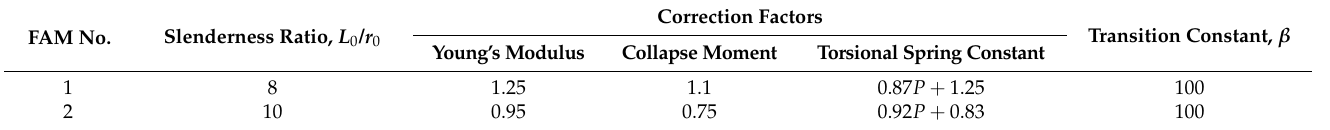
Figure 11. Experiment setup using the linear hydraulic dynamometer (LHD) developed by Chipka et al. [37]. A hydraulic power unit (HPU) is used to actuate the drive cylinder. The fluidic artificial muscle (FAM) is activated using a pneumatic power supply while the force and contraction is measured using a load cell and a linear variable differential transformer (LVDT), respectively. Table 1. Resulting correction factors from empirical parameter tuning.